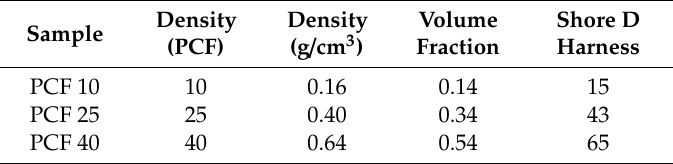
Table 1. Physical properties of polyurethane (PUR) foam